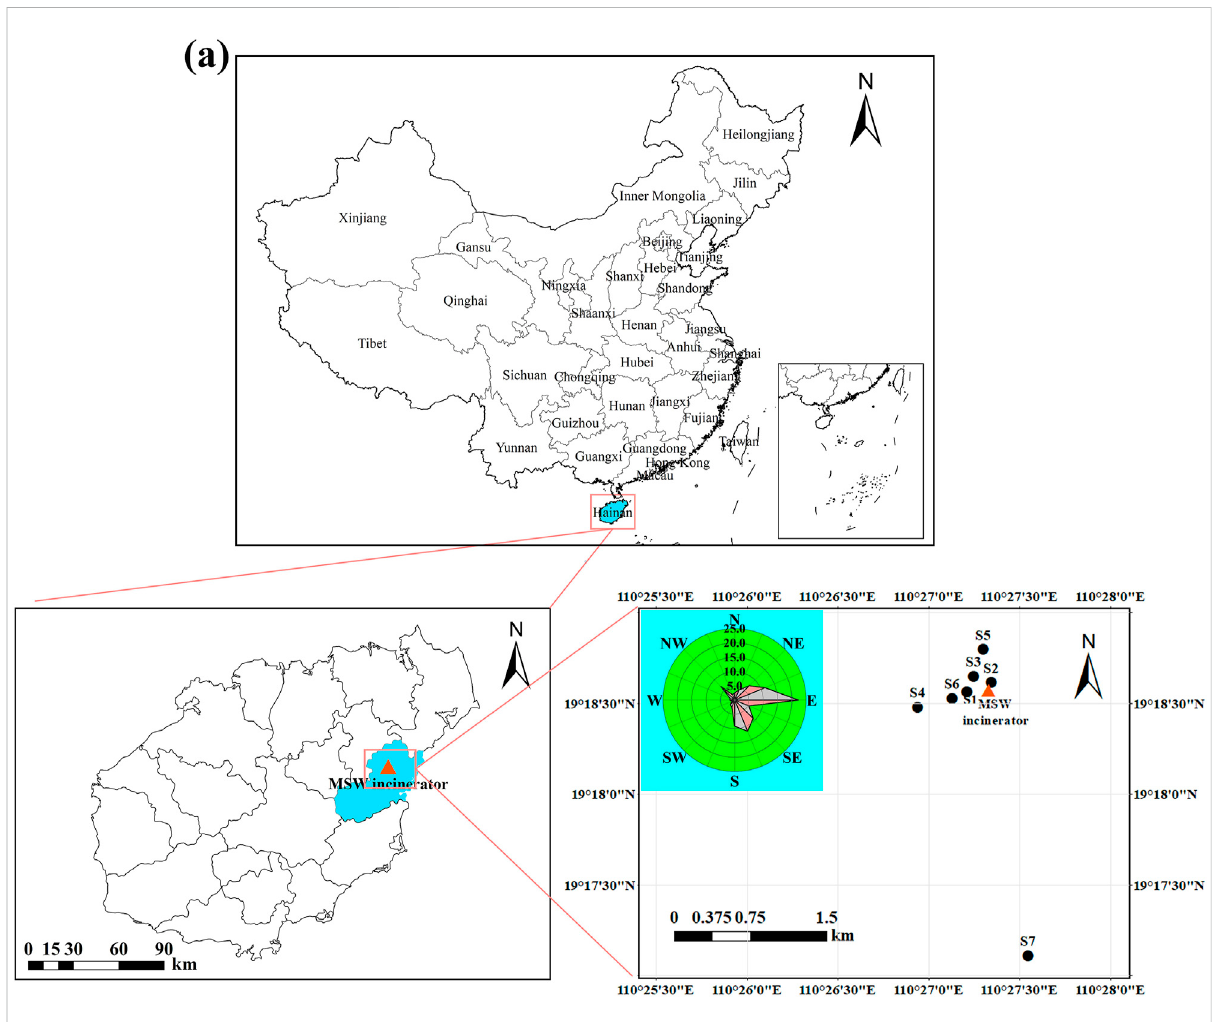
FIGURE 1 Location of the sampling